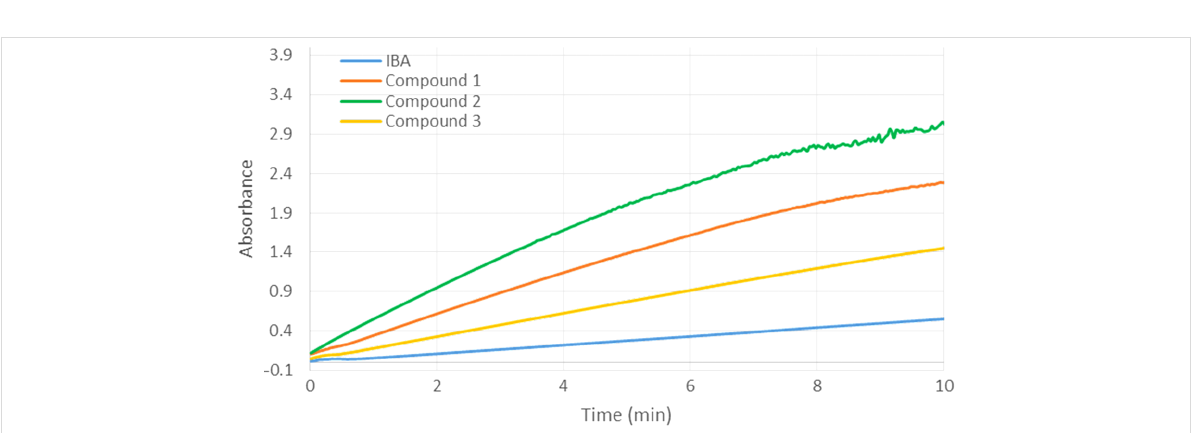
Scheme 3: Synthesis of compound 5 (Tr = trityl).